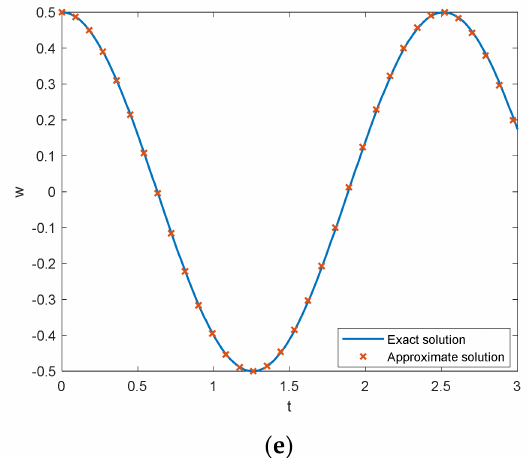
Figure 3. The comparison of approximate solution w = A cos ( ω t + ϕ ) with exact one of Equation (34). ( a ) ( k,a,b ) = (0.8, 0.4, 0.1); ( b ) ( k,a,b ) = (0.6, 0.8, 0.1); ( c ) ( k,a,b ) = (0.3, 0.5, 0.2); ( d ) ( k,a,b ) = (0.6, 0.7, 0.2); and ( e ) ( k,a,b ) = (1, 0.5,